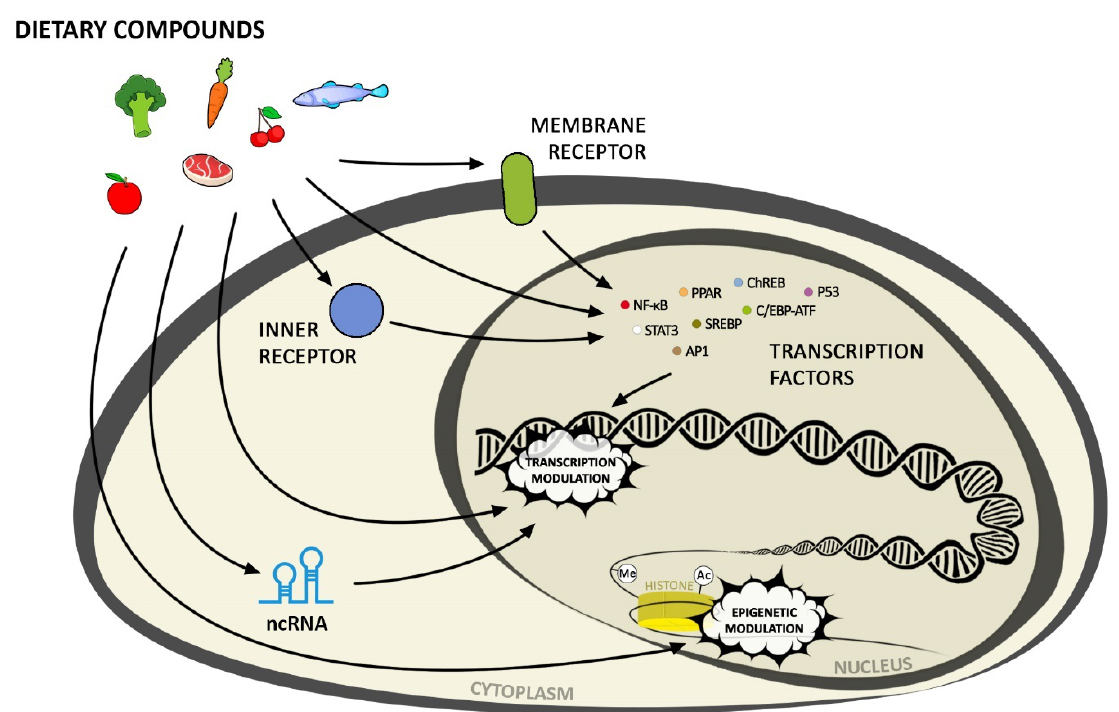
Figure 1. Methods of dietary compound influence on gene expression (for epigenetic modifications -(Me) stands for methyl group in methylated DNA; -(Ac) stands for acetyl group in acetylated histones).